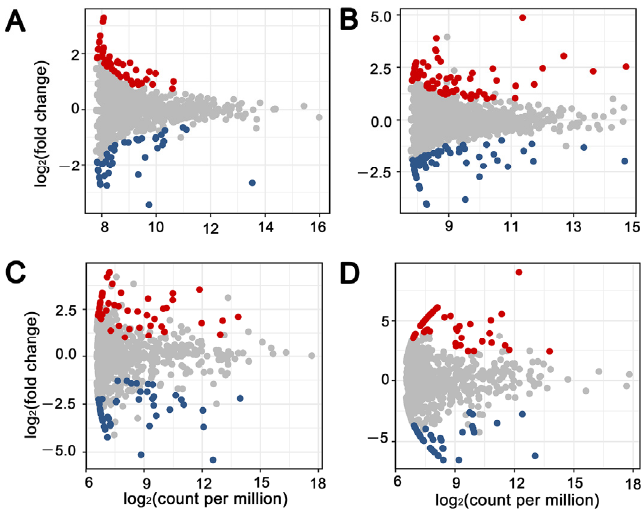
Figure 4. Residue retention treatments were enriched and depleted for certain bacterial OTUs in 2017 ( A ) and 2018 ( B ) and for fungal OTUs in the year 2017 ( C ) and 2018 ( D ). Red, enriched OTUs; blue, depleted OTUs; grey, unaffected OTUs